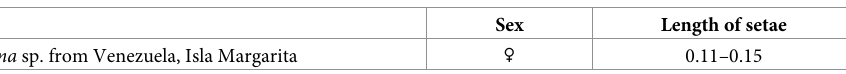
Table 7. Length ranges of subtype I e